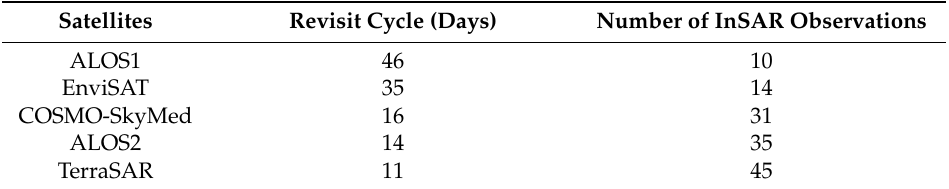
Table 1. Revisit cycles of the five common satellites with SAR sensors, and the number of their simulated InSAR